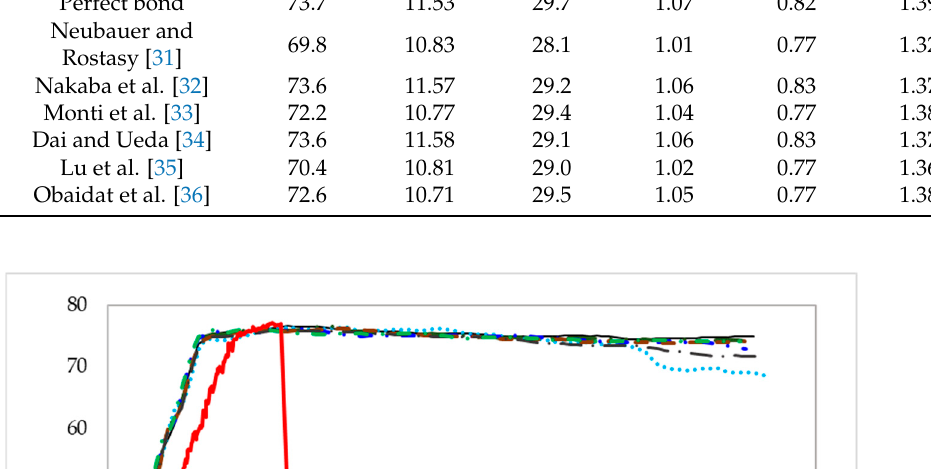
Table 8. FEM predicted results for retrofitted slab compared with experimental data. Constitutive Models